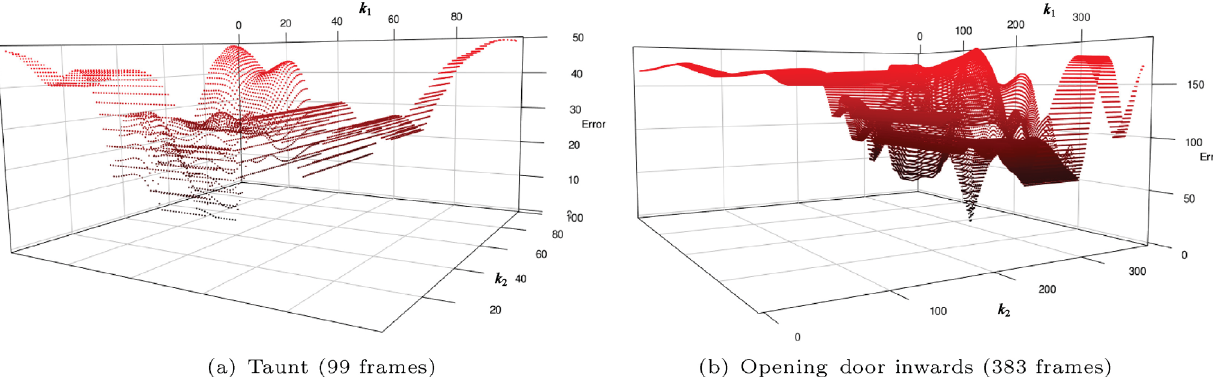
Fig. 4 Finding the optimal set of keyframes to approximate a motion is a difficult problem. Here we show a problem of choosing just two additional keyframes, k 1 and k 2 , to approximate a motion (resulting in the set of keyframes { 1 ,k 1 ,k 2 ,n } , where 1 and n are the first and last frames of the motion). Horizontal axes correspond to k 1 and k 2 , while the vertical axes gives the resulting error. Importantly, note that the problem space is not convex. Instead, it contains multiple extrema and regions that break geometric continuity. When choosing more than two keyframes the dimensionality of the problem space increases and, consequently, both the number of extrema and the number of regions breaking geometric continuity increase. These attributes make optimizing keyframe selection computationally expensive for numerical solvers and genetic algorithms. Note: error values here have been adapted to clarify the visualization: the error values are first scaled so that they span [0 , 1] and then scaled again by half the number of frames in the